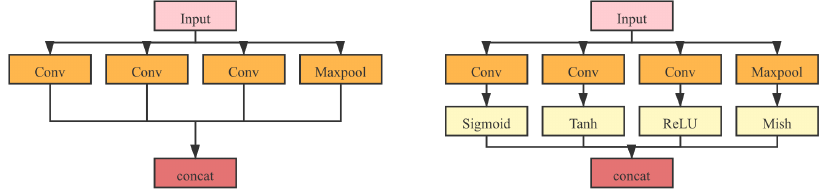
Figure 11. MAF module applied to the GoogLeNet (the original one is on the left; the optimized one is on the